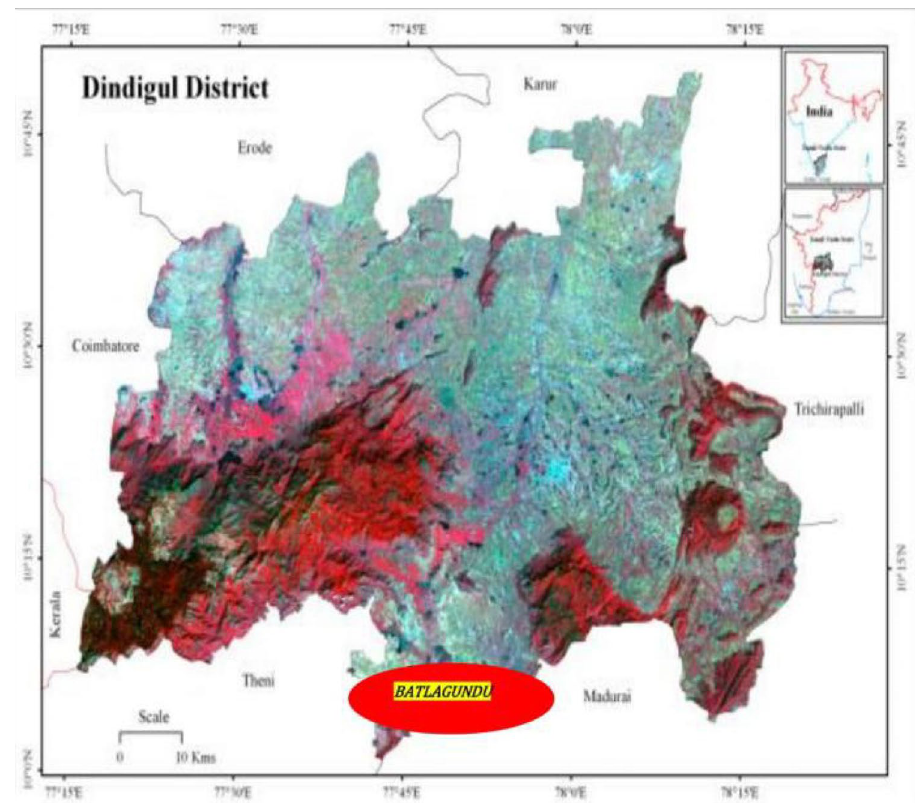
Fig. 1 Map of the study area